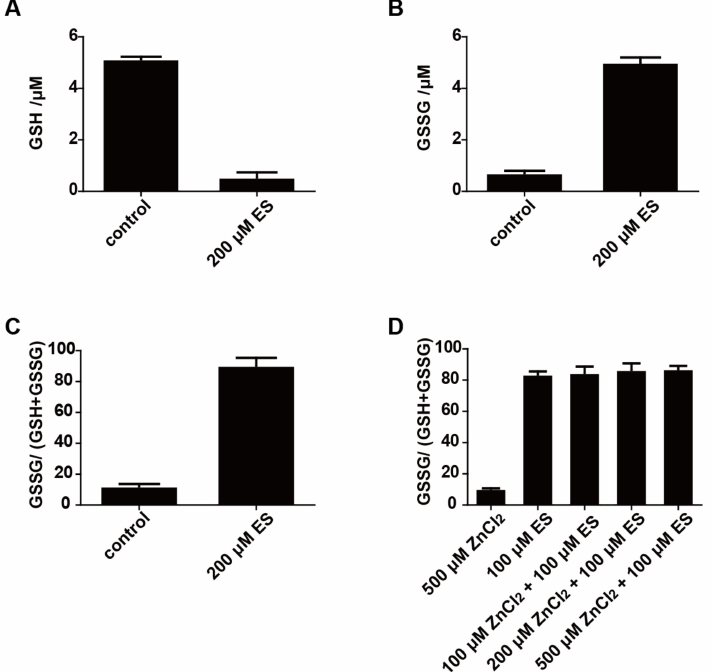
Figure 4. The effect of elemental sulfur on reduced and oxidized glutathione. The concentration of ( A ) GSH and ( B ) GSSG were measured in the resting cells of S. cerevisiae after incubation with elemental sulfur for 30 min. ( C ) The proportion of GSSG is increased after elemental sulfur was incubated with S. cerevisiae resting cells. ( D ) The proportion of GSSG was increased after elemental sulfur was incubated with S. cerevisiae resting cells in the presence of up to 500 µ M ZnCl 2 . The S. cerevisiae resting cells used was at an OD 600nm of 2.0. Data are averages of three parallel experiments with standard deviations. ES, elemental